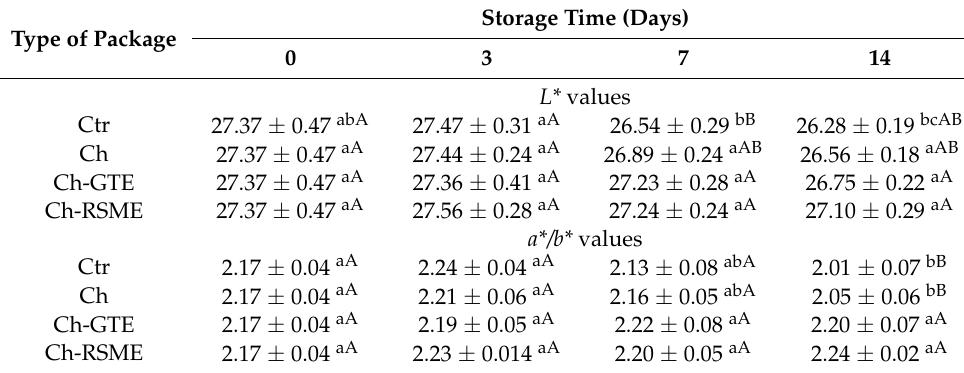
Table 1. Changes in color values ( L* and a*/b* ) of packaged raspberry ( Rubus idaeus L. cv. ‘Kweli’) fruits (no film-pad _Ctr; with film-pad containing green tea extract_Ch + GTE, rosemary extract_Ch + RSME and only chitosan_Ch) stored for 14 days at 4 ◦ C under passive MAP